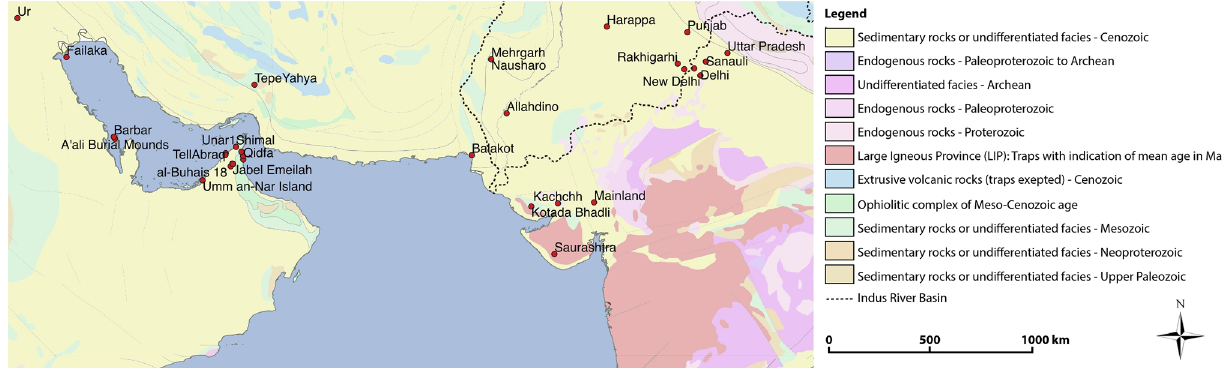
Figure 3. Sites mentioned in the text that have associated faunal, human and/or botanical strontium isotope data. The geological basemap 56 was accessed using OneGeology 57 , with the addition of Indus River